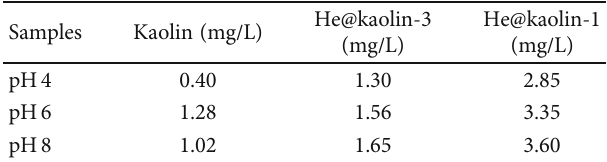
Figure 7: Removal ratio of As(III) by kaolin, He@kaolin-1, and He@kaolin-3 at di ff erent pH values of 4, 6, and 8. Table 2: Removal amount of As(III) by kaolin, He@kaolin-1, and He@kaolin-3 at di ff erent pH of 4, 6, and